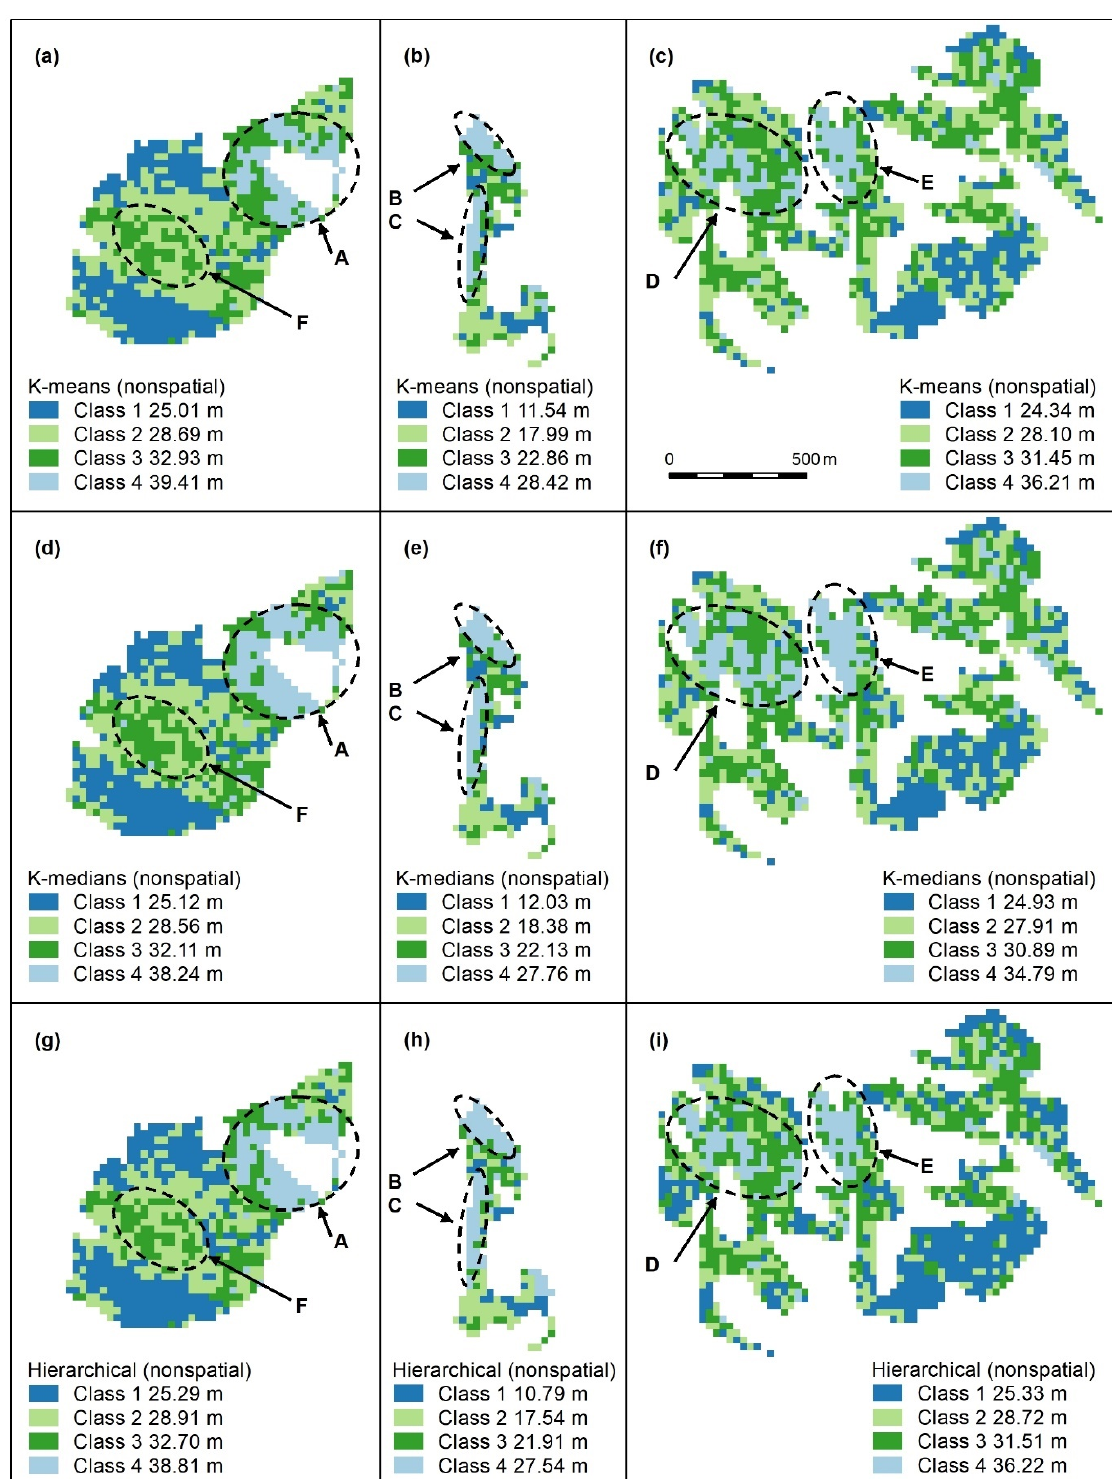
Figure A8. Nonspatial algorithm cluster maps, K ‐ means ( a – c ), K ‐ medians ( d – f ) and hierarchical ( g – i ) with 4 classes. Letters A–F indicate areas of higher canopy, K ‐ medians ( d – f ) best captures all the features, but D and F are not contiguous. B and C are captured in all maps, with little difference between algorithms. Panel scores: K ‐ means = 11, K ‐ medians = 15, and Hierarchical = 12.